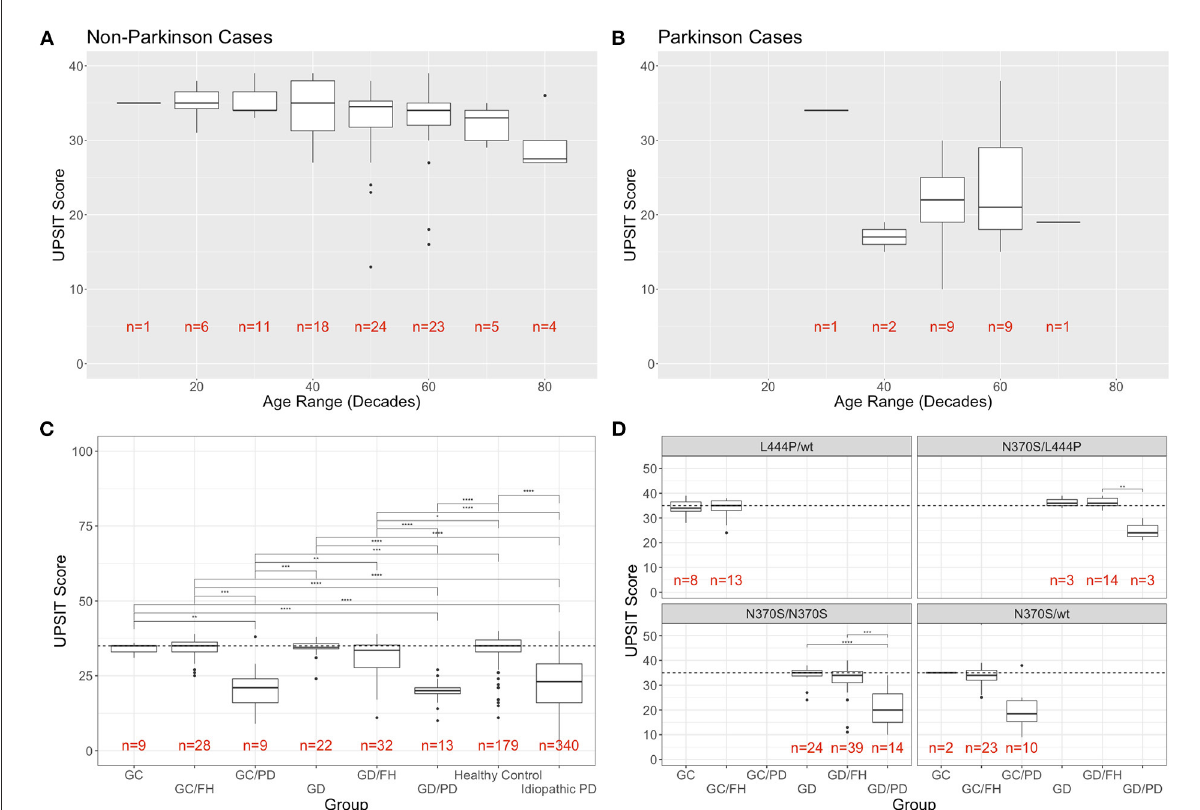
FIGURE1 Distribution of UPSIT scores by age, group, and genotype. (A) Individuals without PD decline in olfactory identification scores (taken at the initial visit) with increasing age, while this trend was not observed in patients with PD (B). (C) Mean UPSIT scores at the most recent visit are shown for each group (GC, GBA1 carriers; FH, family history; GD, Gaucher disease; PD, Parkinson’s disease). For comparison, the data from the cases of idiopathic PD and controls from the PPMI cohort is included in the far right. (D) Breakdown of UPSIT scores by disease group and most